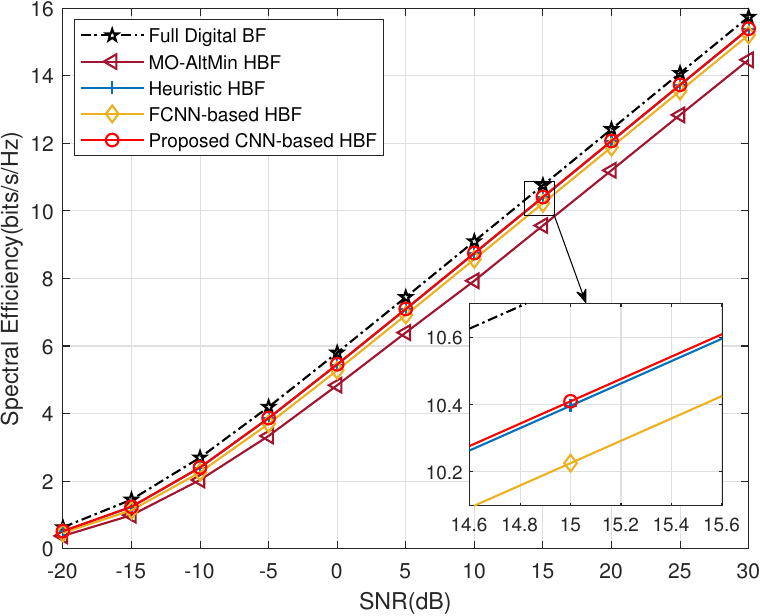
Figure 7. Comparison of spectral efficiency performance under different schemes in Rayleigh fading channel with N t =